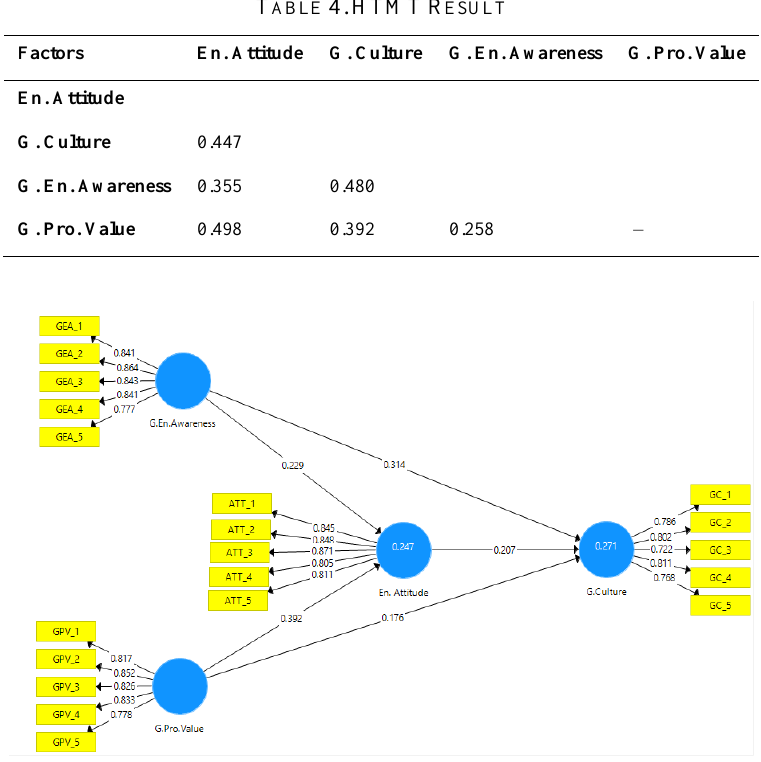
Fig. 2. Measurement Model: PLS – Algorithm (Outer